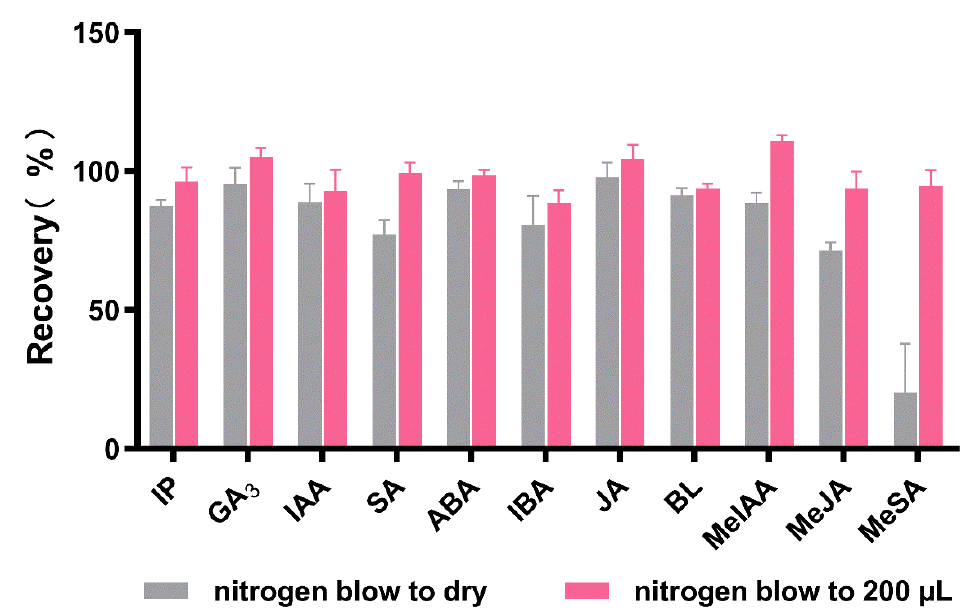
Figure 5. The effects of nitrogen blowing to dry and to 200 µ L on recoveries of 11 phytohormones ( n = 3).